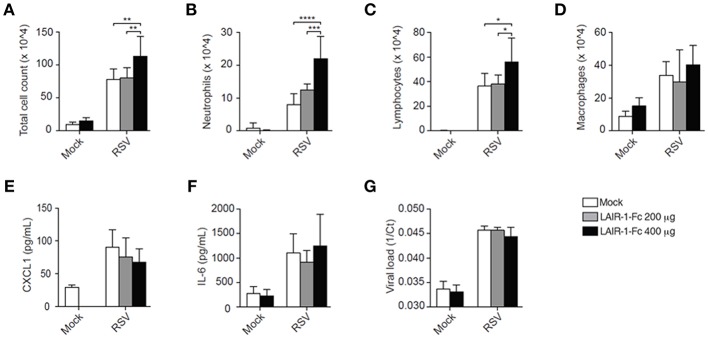
LAIR-1-Fc chimeric protein administration effects pulmonary neutrophil recruitment during RSV infection. (A–G) Wild-type BALB/c mice were inoculated intranasally with RSV and sacrificed on day 5. One day before RSV inoculation and 2 days after inoculation mice were treated intraperitoneally LAIR-1-Fc fusion protein or PBS (vehicle). Total (A) and differential (B–D) BAL cell counts, BAL CXCL1 (F) and IL-6 concentrations (G), and viral load (G) were determined. Data are presented as means ± SD and represent 6 mice per group for panels (A–G) in 2 independent experiments. *p < 0.05, **p < 0.01, ***p < 0.001, ****p < 0.0001. 2-way ANOVA with Holm-Šídák multiple comparison correction.